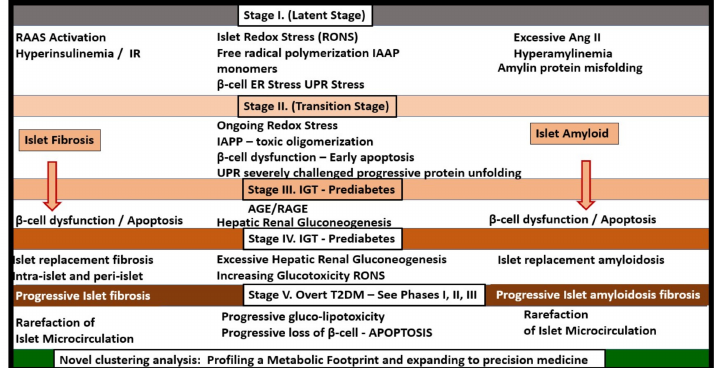
Figure 4. T2DM is a progressive disease consisting of five stages in the natural history of T2DM. T2DM implicates metabolic syndrome, redox stress, islet amyloid, islet fibrosis and RAAS. T2DM is the